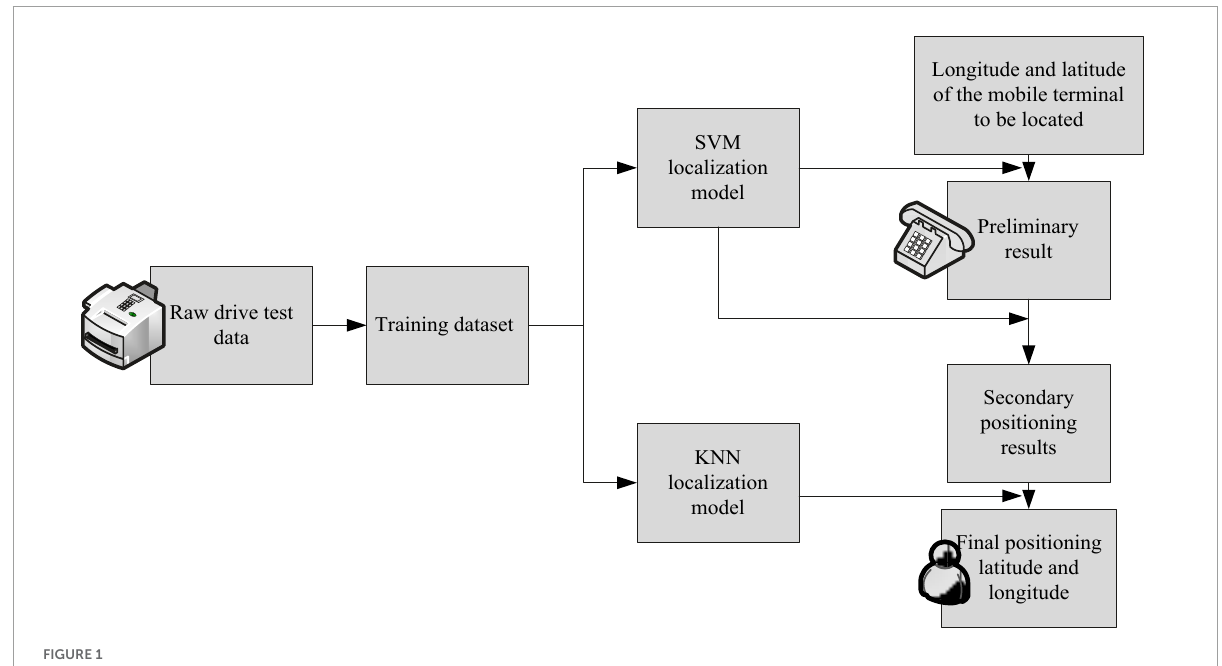
FIGURE1 Flow chart of three-stage localization based on SVM and k-nearest neighbor